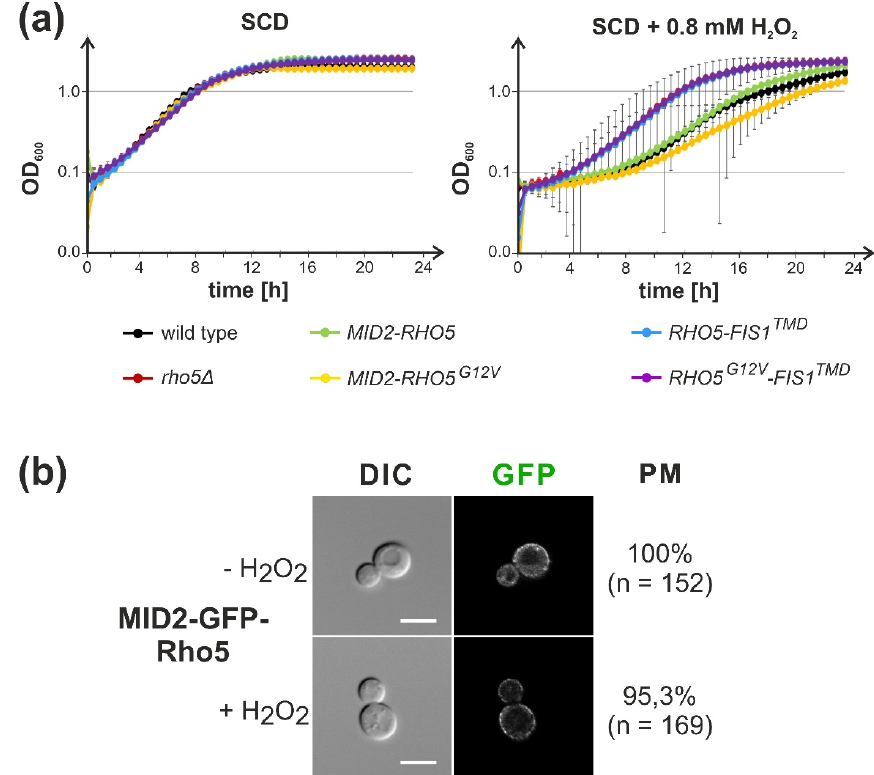
Figure 4. A fusion of Rho5 to the plasma membrane sensor Mid2 still functions in the oxidative stress response. ( a ) Growth of strains carrying the indicated fusions with RHO5 either at the MID2 locus ( MID2-RHO5, MID2-RHO5 G12V ) or integrated with plasmid pJJH3024 at the leu2-3,112 locus ( RHO5-FIS1 TMD ) was followed under standard conditions ( left ) and under oxidative stress ( right ). Wild-type and rho5 deletion strains were included as controls. Error bars give the standard deviations from growth recorded in duplicate for two independent strains, each, with the exception of MID2-RHO5 G12V , for which only one strain was constructed. Strains employed were: wild type = FSO4-3A and FSO4-8A, rho5 = FSO4-3D and FSO4-8B, MID2-RHO5 = HOD500-10A and HOD500-11B, MID2-RHO5 G12V = HFSO83, RHO5-FIS1 TMD = LBO130 and LBO132, RHO5 G12V -FIS1 TMD = HOD529-2B and HOD529-2B. ( b ) Mid2-GFP-Rho5 fusions are confined to the plasma membrane with and without oxidative stress. Strain HOD512-3A was subjected to life cell fluorescence microscopy and representative bright-field (DIC, left panels) and fluorescence images (GFP channel; right panels) are shown. Percentages of cells with localization of the fusion protein at the plasma membrane (PM) were calculated from the total number of cells (n)